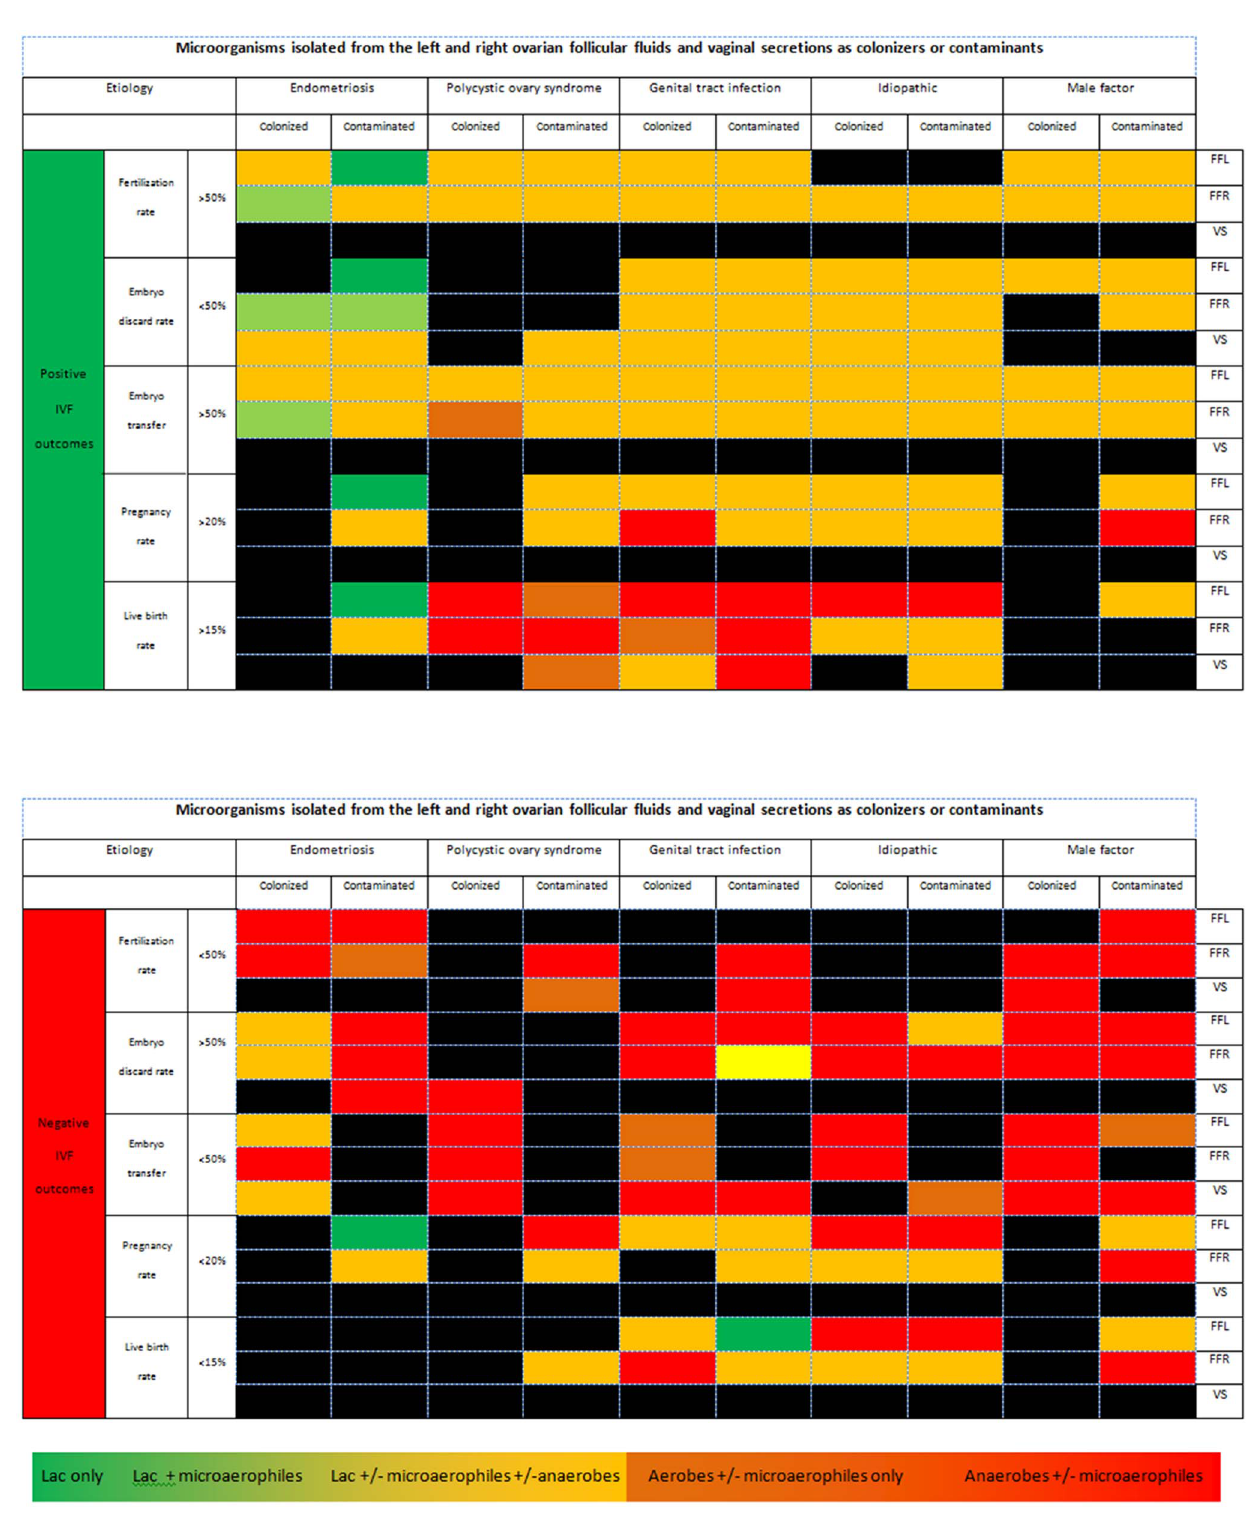
Figure 3. Heat map depicting IVF outcomes for fertile and infertile women with microorganisms detected from genital tract secretions during IVF cycles. Standard microbiological culture techniques were used to isolate and identify resident microorganisms from clinical specimens obtained from 262 women. Data represents the results obtained from culturing 262 vaginal swabs and 462 follicular fluids. All specimens were cultured on/in a range of microbiological culture media and broth. The heat map consists of a graphical two-dimensional matrix of colored squares, where each square represents the combined observations of the microorganisms isolated from all samples in each etiological cohort. The color of the square is dependent on the composition of the microorganisms at each anatomical site (FFL – left follicular fluid, FFR – right follicular fluid, VS – vaginal swab). Dark green squares represent specimens where only Lactobacillus spp. were isolated, light green squares represent